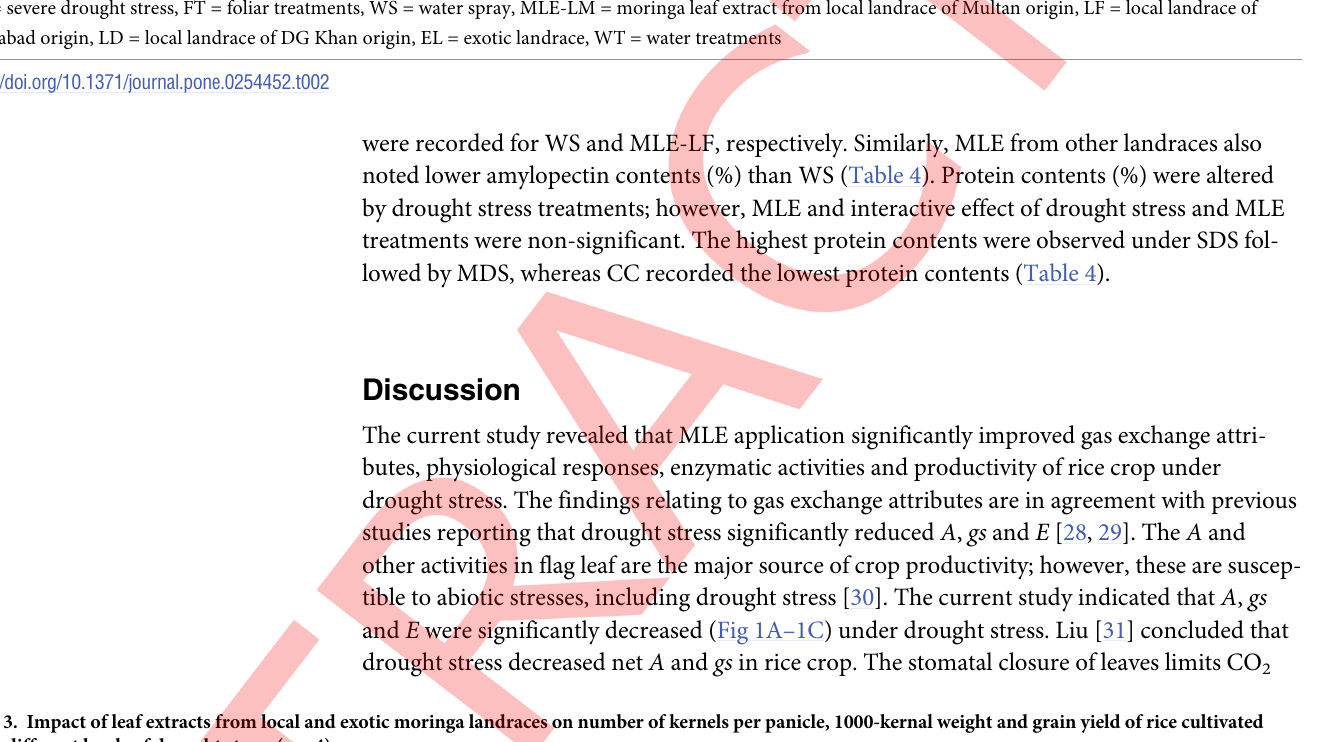
Table 2. Impact of leaf extracts from local and exotic moringa landraces on plant height, number of productive tillers and panicle length of rice cultivated under different levels of drought stress (n = 4). Treatments Plant height (cm) WS 108.25 MLE-LM 116.25 MLE-LF 119.00 MLE-EL 112.75